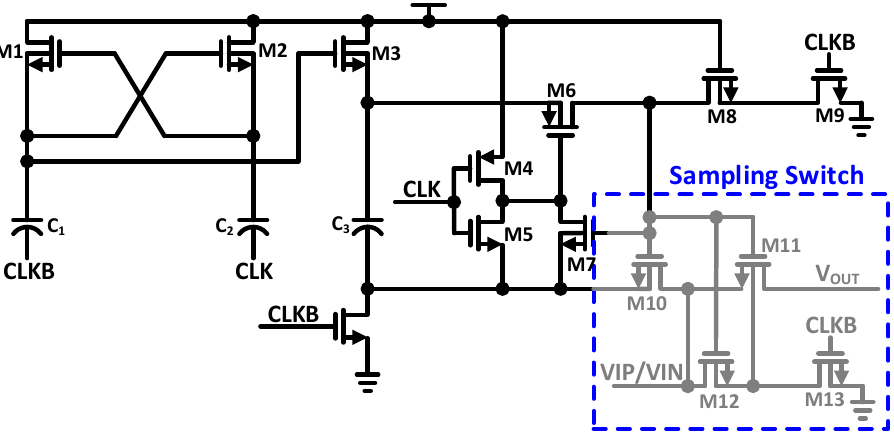
Figure 8. Bootstrap Switching Schematic.